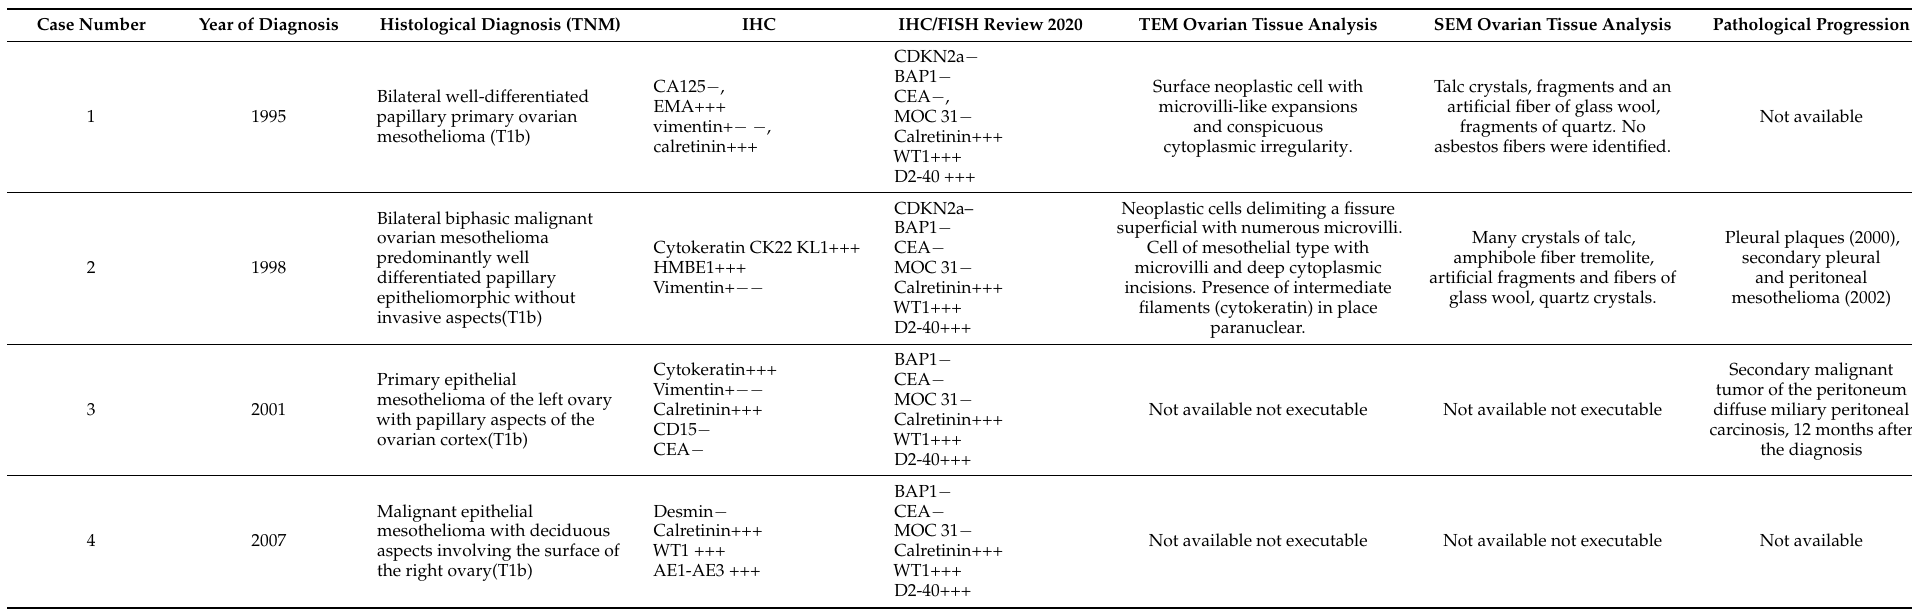
Table 2. Morphological, immunohistochemical and ultrastructural features of ovarian